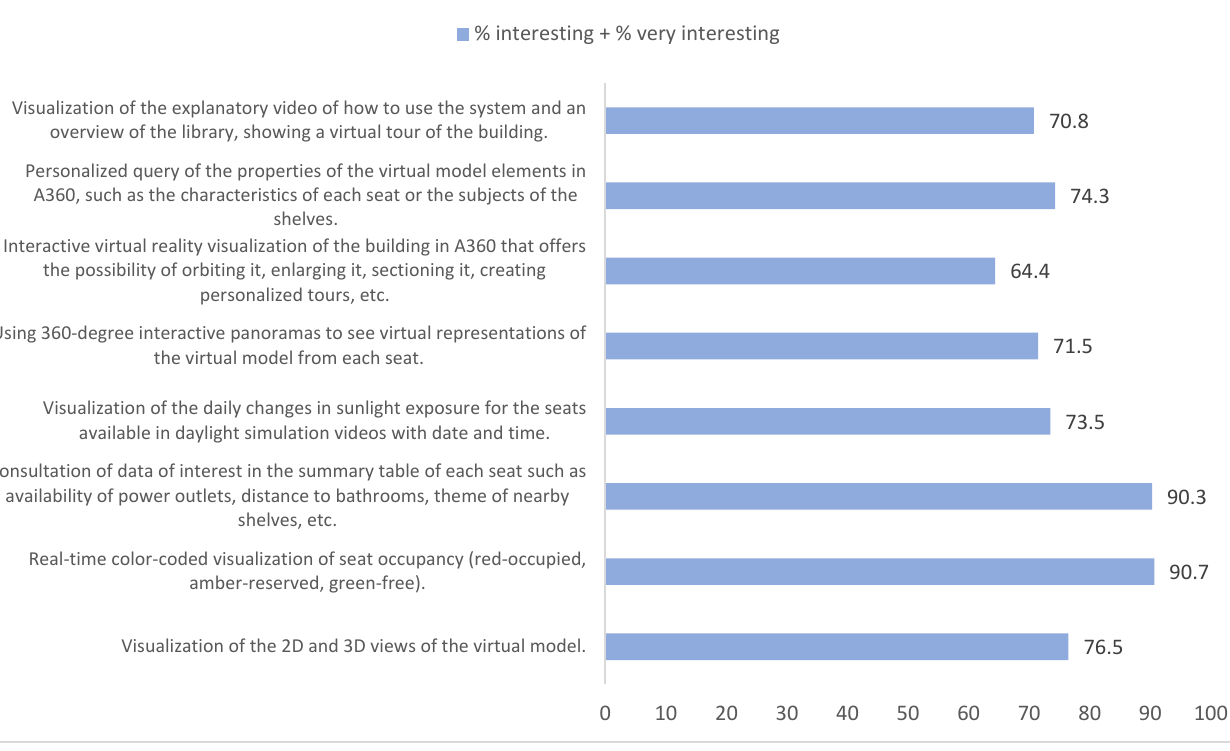
Figure 15. Degree of interest in the visual information offered by Biblio-Smart applying BIM. Table 5. Comparative assessment of Biblio-Smart compared with other reservation systems